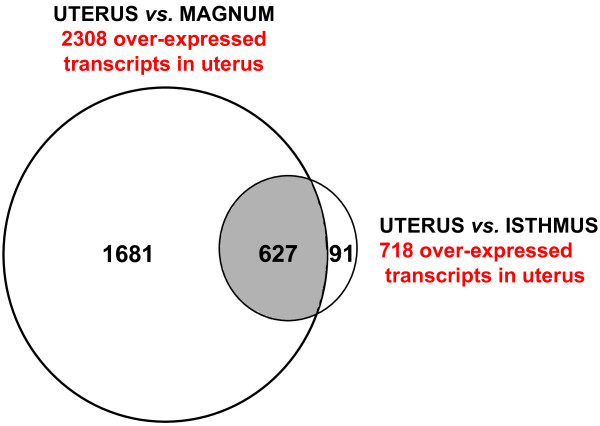
Venn diagram of over-expressed genes in the uterus compared with the magnum and white isthmus.